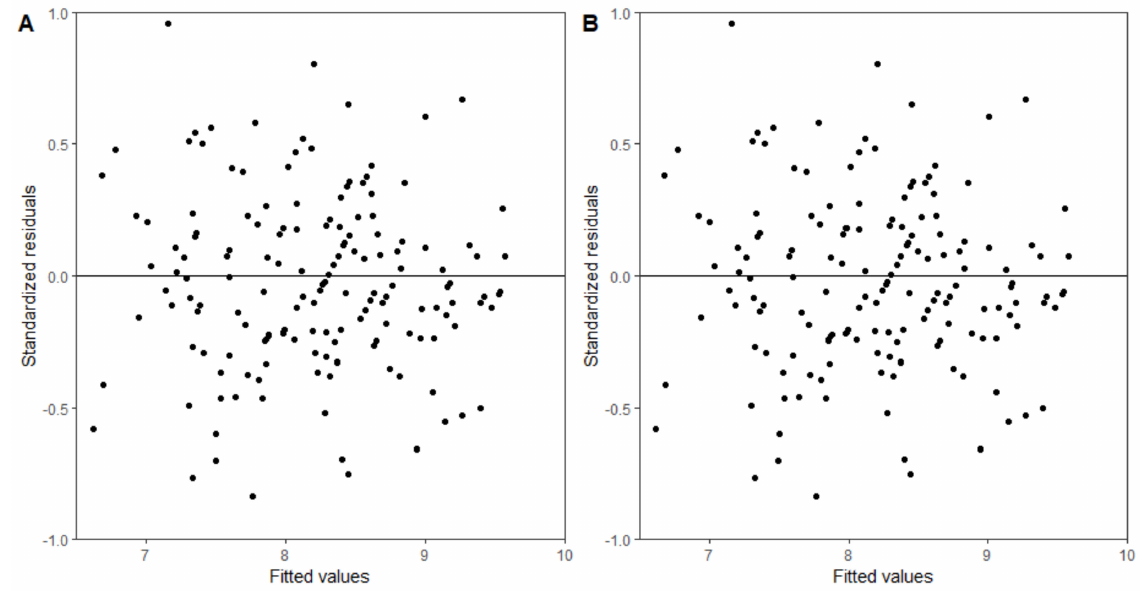
Figure 4. Residuals of NLME HCB models: M7 ( A ) and M8 ( B ) at the sample plot-level. The AIC, BIC, and -2log likelihood values of different models are shown in Table 8. The AIC, BIC, and -2log likelihood calculated by the model with the random effects parameters is smaller than that of the model fitted with the ordinary least square regression method (also known as traditional modeling method). It indicates that adding random effects parameters does not lead to over parameterization, and could prove that the mixed-effects model was more appropriate than the traditional model for HCB